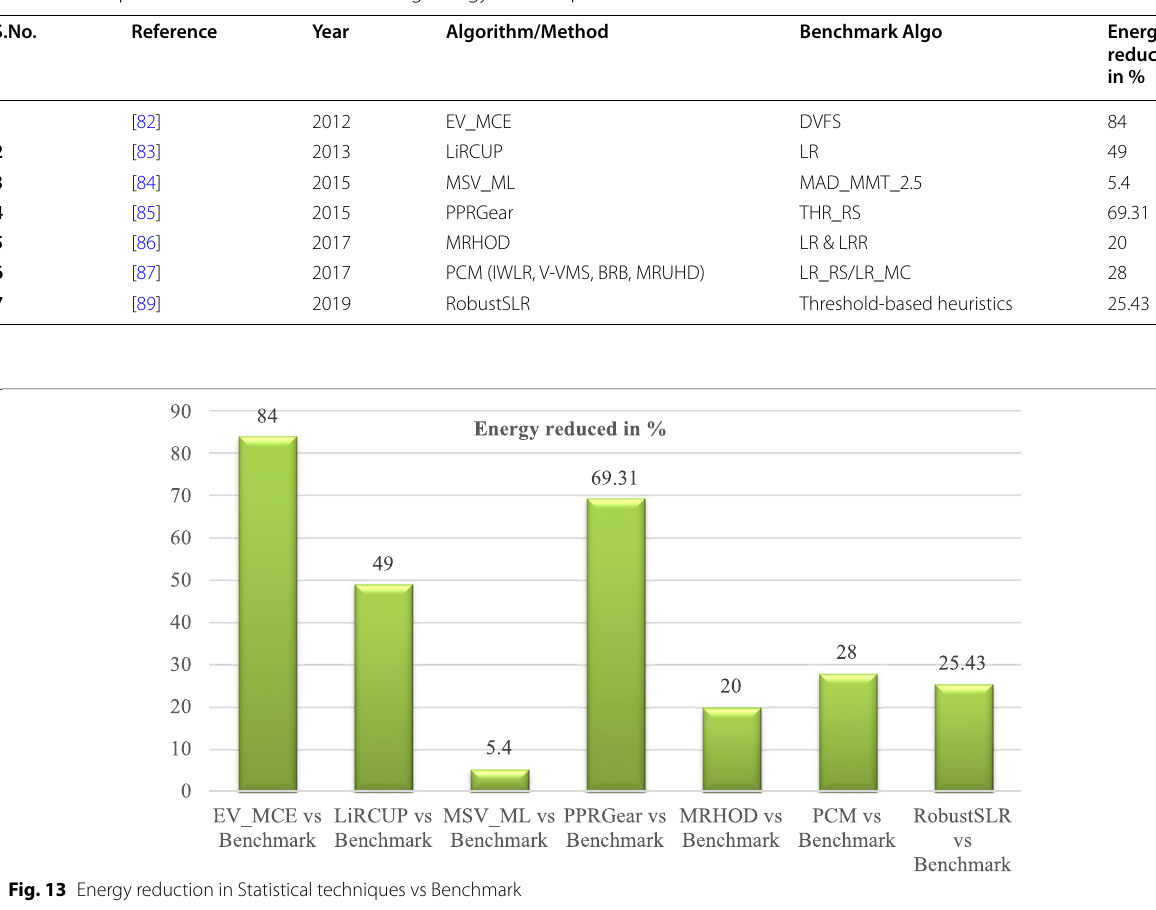
Fig. 13 Energy reduction in Statistical techniques vs Benchmark